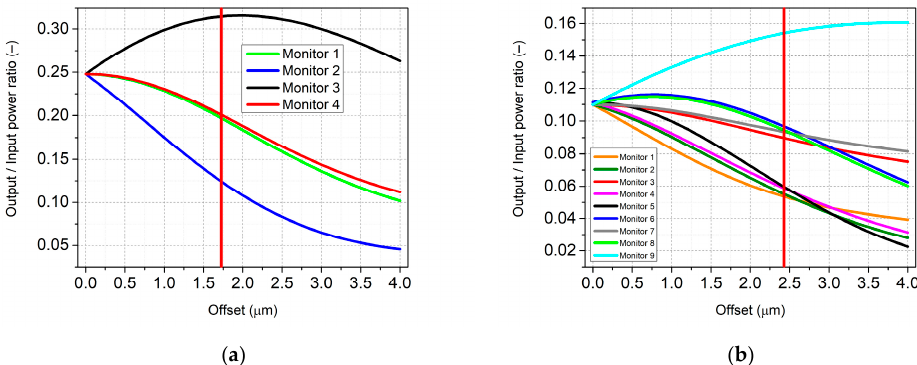
Figure 11. Power distribution at the end of the MMI couplers against varying offsets of the input fibre: ( a ) 1 × 4 MMI; ( b ) 1 × 9 MMI. The modal field distributions of both splitters with the maximum allowed fibre offset are shown in Figure 12. All of the outputs are still separated from each other. The output with the highest power is the closest to the shifted input axis of the MMI splitter, and the one with the lowest power is the one furthest from the shifted input axis. The output modal field positions are also shifted, and their shapes show some degree of distortion. The splitters in which the fibre serves as the input waveguide thus retain their function, with the fibre offset up to 1.7 μ m in case of the 1 × 4 splitter and up to 2.4 μ m in case of the 1 × 9 splitter.